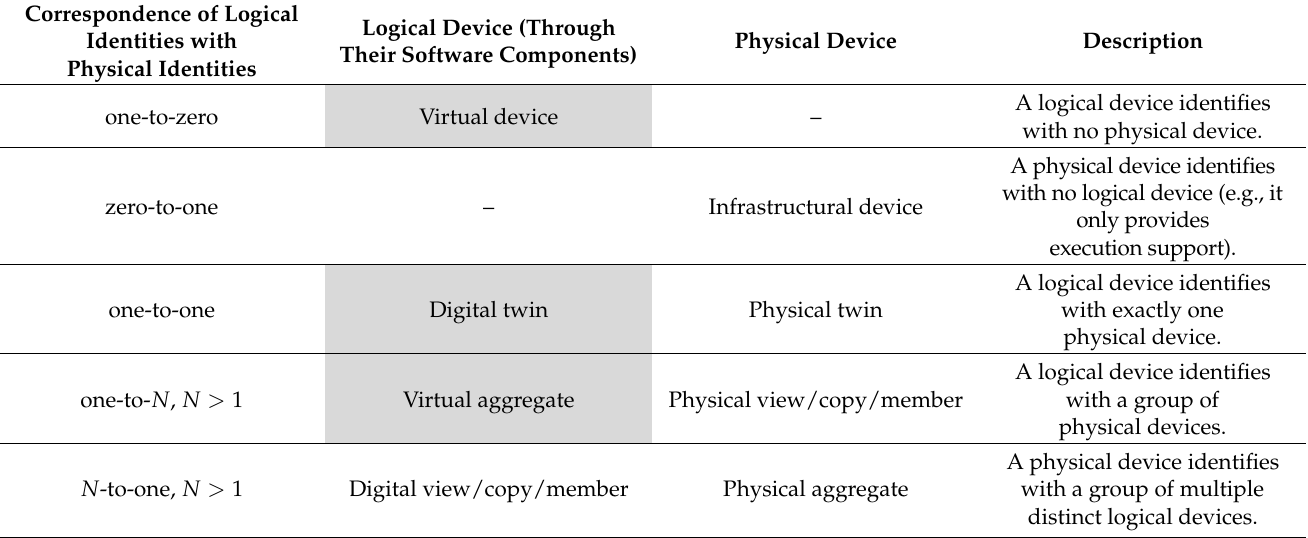
Table 2. Different identity relations between cyber and physical nodes help us derive different concepts (and corresponding terms). This paper has an explicit focus on the notions in the highlighted